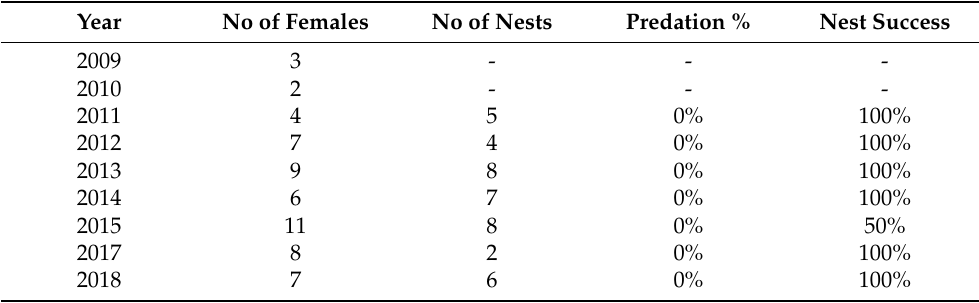
Table 1. Numbers of individual nesting females found in each year of the study, the number of nests located, and the predation rate and nest success of those nests. Nest success is defined as the percent of nests that had at least some successful hatchlings emerge. Lower numbers of females in 2009–2010 are likely due to limited sampling effort in those years. No of Females No of Nests Predation